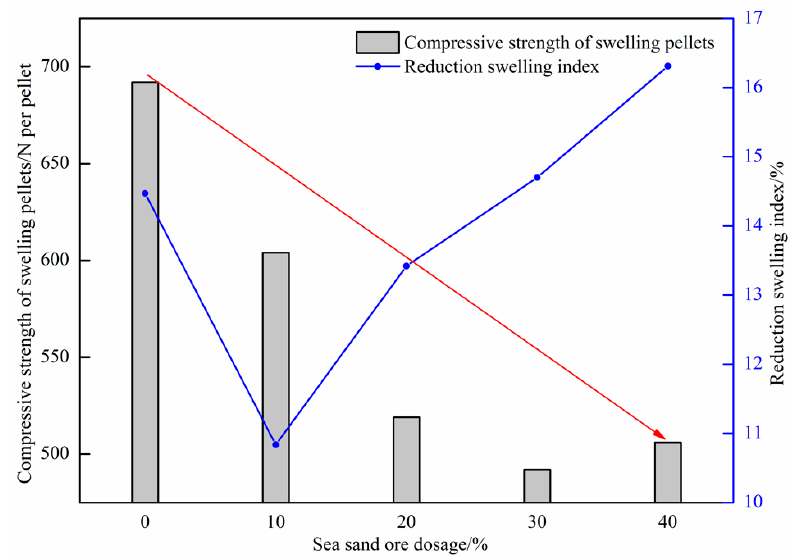
Figure 12. Effect of sea sand ore dosage on the reduction swelling index of the oxidized pellets and compressive strength of the swelling pellets.